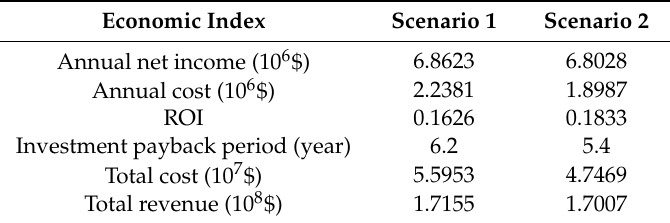
Table 7. Economic